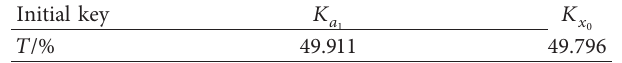
Table 5: Sensitivity analysis of initial value. Initial